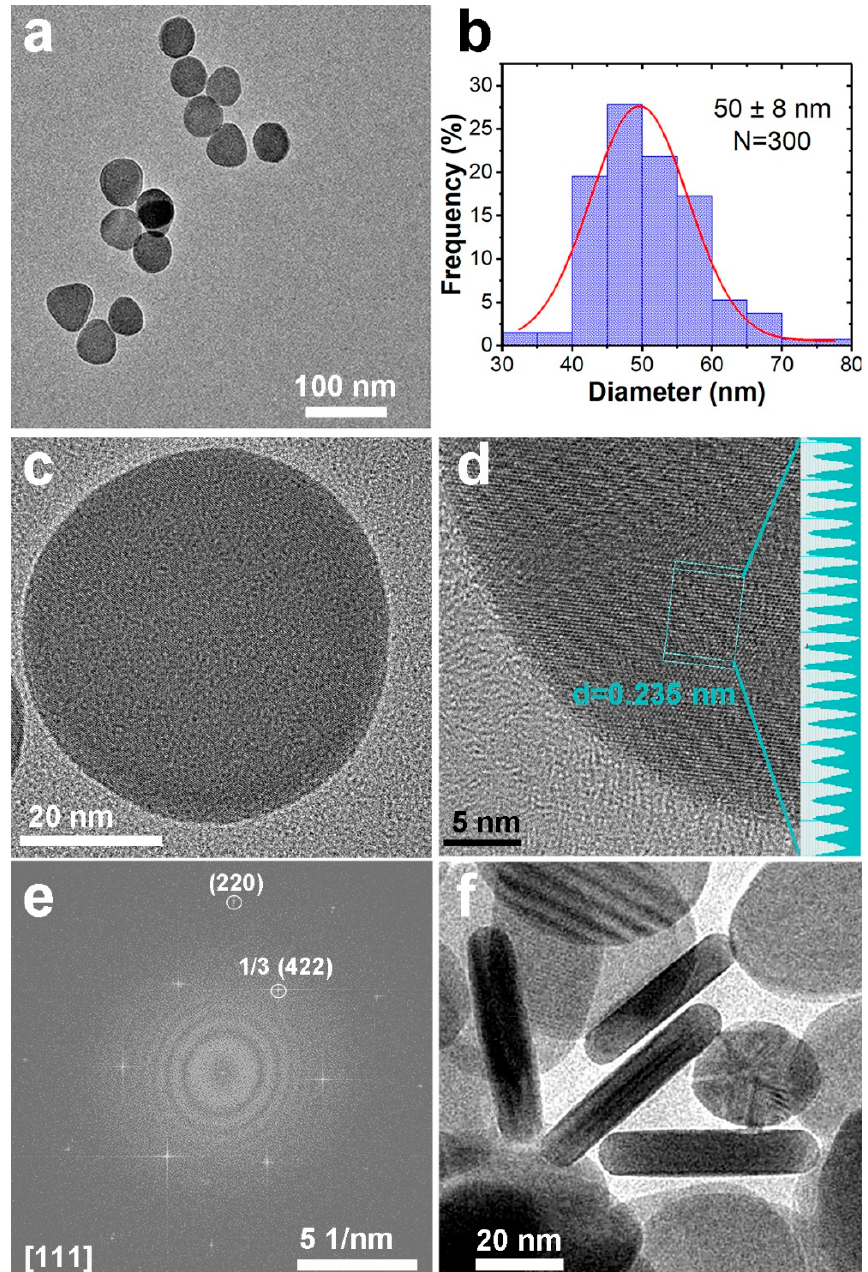
Figure 1. Characterization of the AgND labels. ( a ) Representative TEM image of the as-prepared AgNDs. ( b ) Histogram of the AgND diameter obtained by measuring 300 randomly selected AgND particles. ( c ) An expanded TEM image of a single AgND. ( d ) HRTEM image of part of the AgND face. ( e ) The corresponding selected area electron diffraction (SAED) pattern via fast Fourier transform of the particle shown in frame c. ( f ) A typical TEM image showing some AgNDs oriented perpendicular to the grid.